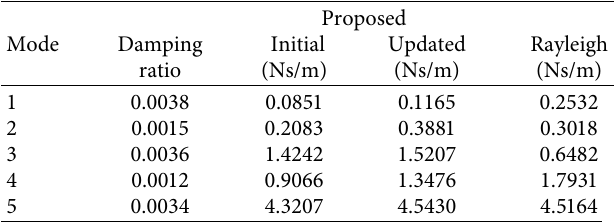
Table 11: Values of the diagonal elements of modal damping matrix for the first 5 modes before and after